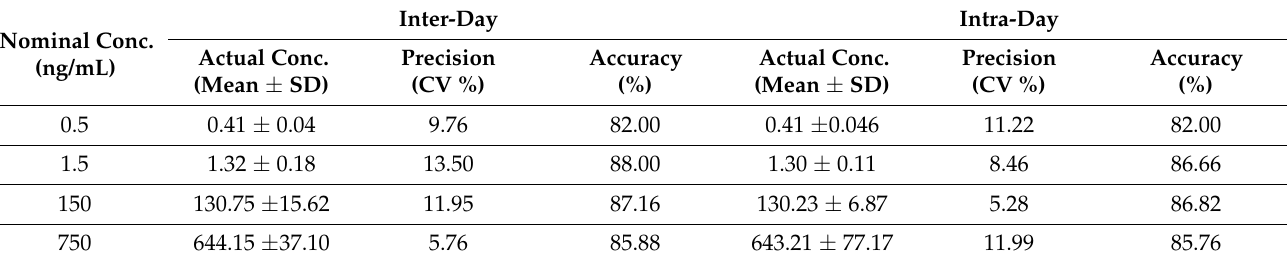
Table 2. Inter- and intra-day precision and accuracy of ERDA in plasma.